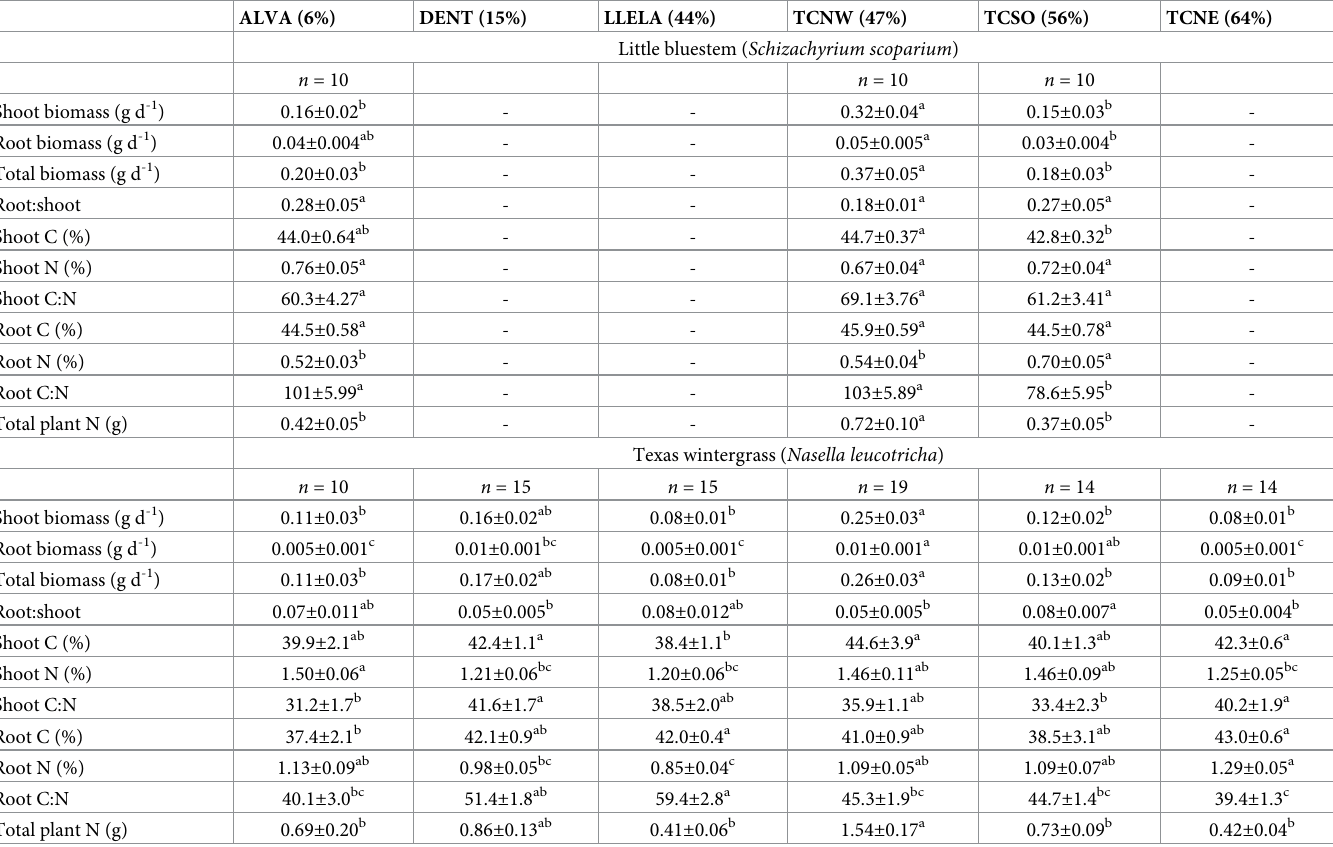
Table 2. Plant traits (mean ± 1SE) for the six phytometer sites along an urban development gradient (indicated in